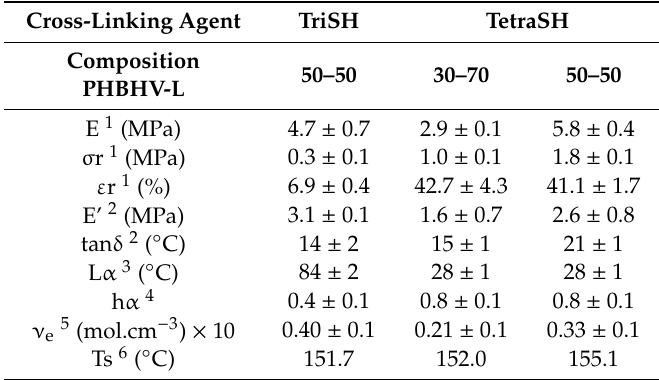
Figure 6. Tan δ curves of PHBHV-L co-networks (typical curves): ( a ) 30–70 PHBHV-L TetraSH; ( b ) 50–50 PHBHV-L TetraSH; ( c ) 50–50 PHBHV-L TriSH. Table 4. Thermo-mechanical characterization of the PHBHV-L-co